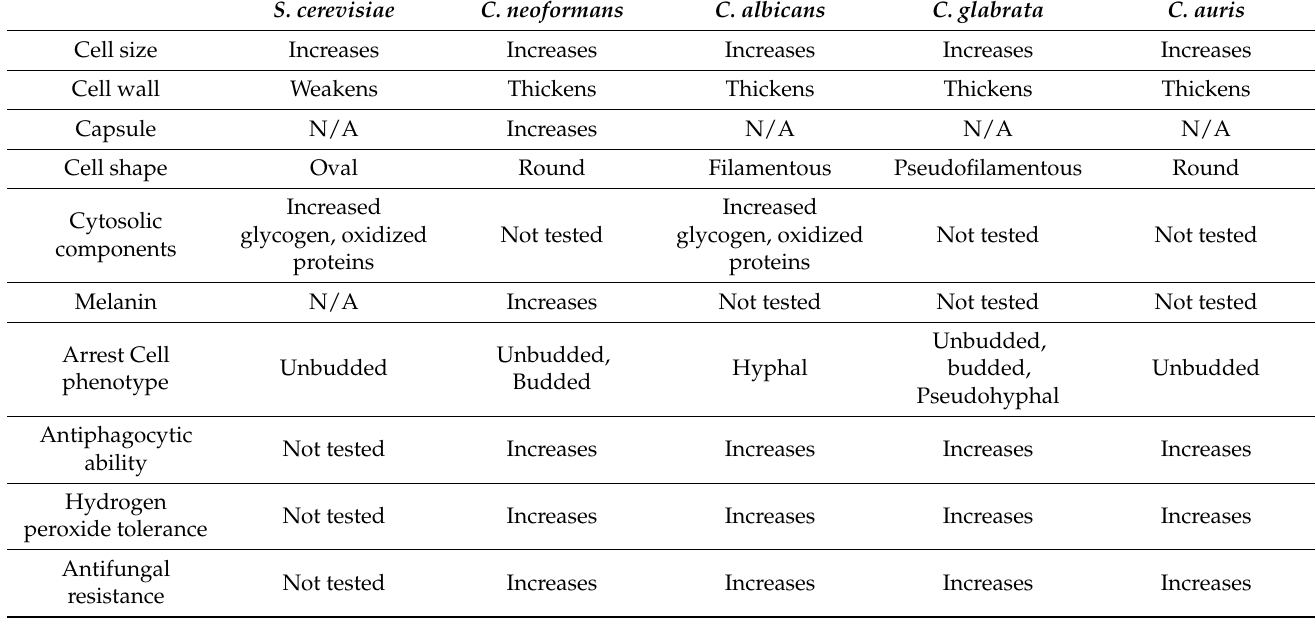
Table 2. Summary of phenotypes associated with increasing replicative